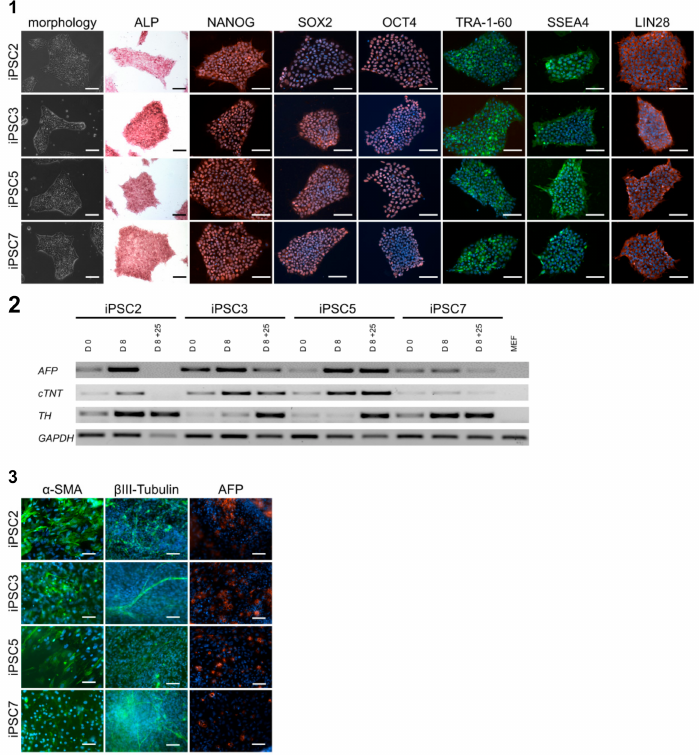
Figure 3. Characteristics of human induced pluripotent stem cells (iPSCs) derived from mucosa mesenchymal stem cells (mMSCs). ( 1 ) Generated iPSC-lines (iPSC2, 3, 5, 7) show typical morphology, are positive for alkaline phosphatase (ALP) activity, and show protein expression of pluripotency- related markers NANOG, SOX2, OCT4, TRA1-60, SSEA4, LIN28. Nuclei were stained with 4 (cid:48) ,6- diamidino-2-phenylindole (DAPI) (scale bars 100 µ m). ( 2 – 3 ) In vitro spontaneously differentiated iPSCs into embryoid bodies (EB) and analyzed for the presence of derivatives of all three germ layers. ( 2 ) Gene expression of endodermal α -fetoprotein (AFP), mesodermal cardiac troponin T (cTNT), and ectodermal tyrosine hydroxylase (TH) was upregulated during spontaneous differentiation (day 8, day 8 + day 25). GAPDH was used as a housekeeping gene, and mouse embryonic fibroblasts (MEFs) were used as negative control. ( 3 ) Immunostaining of EB outgrowths revealed the expression of endodermal AFP, mesodermal ( α -SMA), and ectodermal ( β III-tubulin) marker proteins. Nuclei were stained with DAPI (scale bars 100 µ